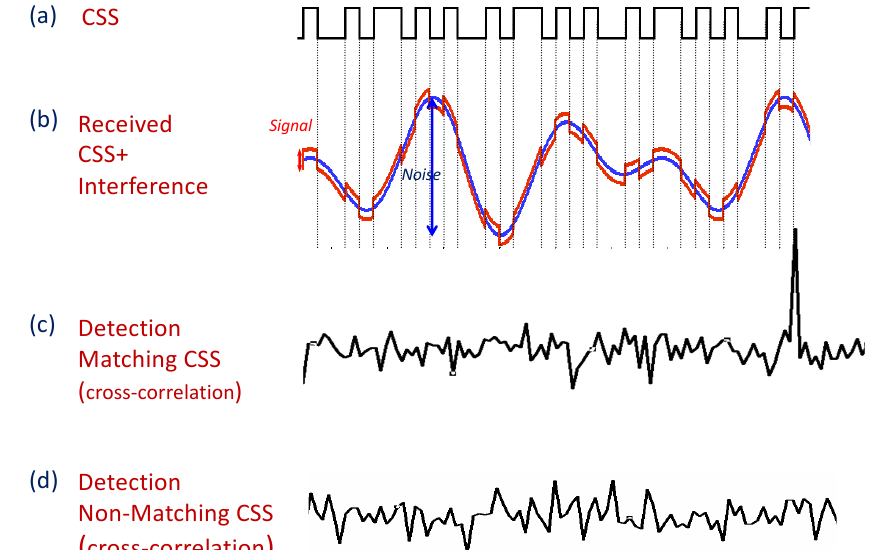
Figure 3. A device utilizes Correlatable Symbol Sequences (CSSs) to convey its identity. The receiver (sink) detects the specific CSS by cross-correlating it with the incoming samples. ( a ) CSS- predefined binary codeword (sequence). ( b ) CSS+Interference as received by the receiver (sink). ( c ) CSS detection process via cross-correlation. The receiver (sink) cross-correlates the incoming samples with the pre-defined CSSs. Cross-correlating with a matched CSS obtains a spike value. ( d ) Cross-correlating with a non-matched CSS does not produce spike